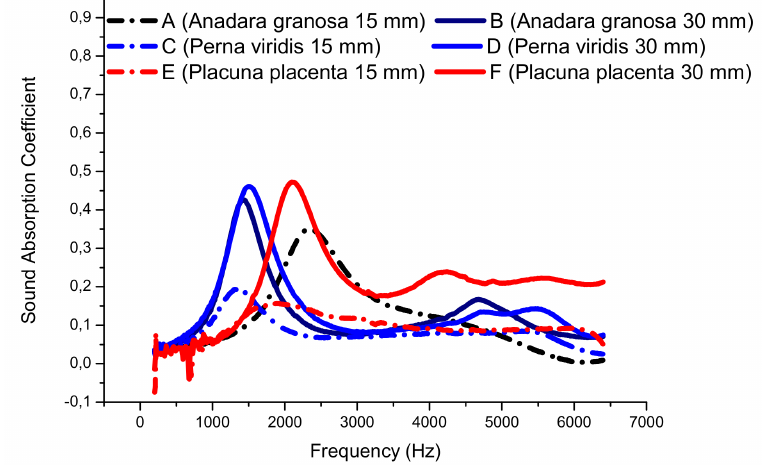
Figure 3. The absorption coefficient of seashell composite without